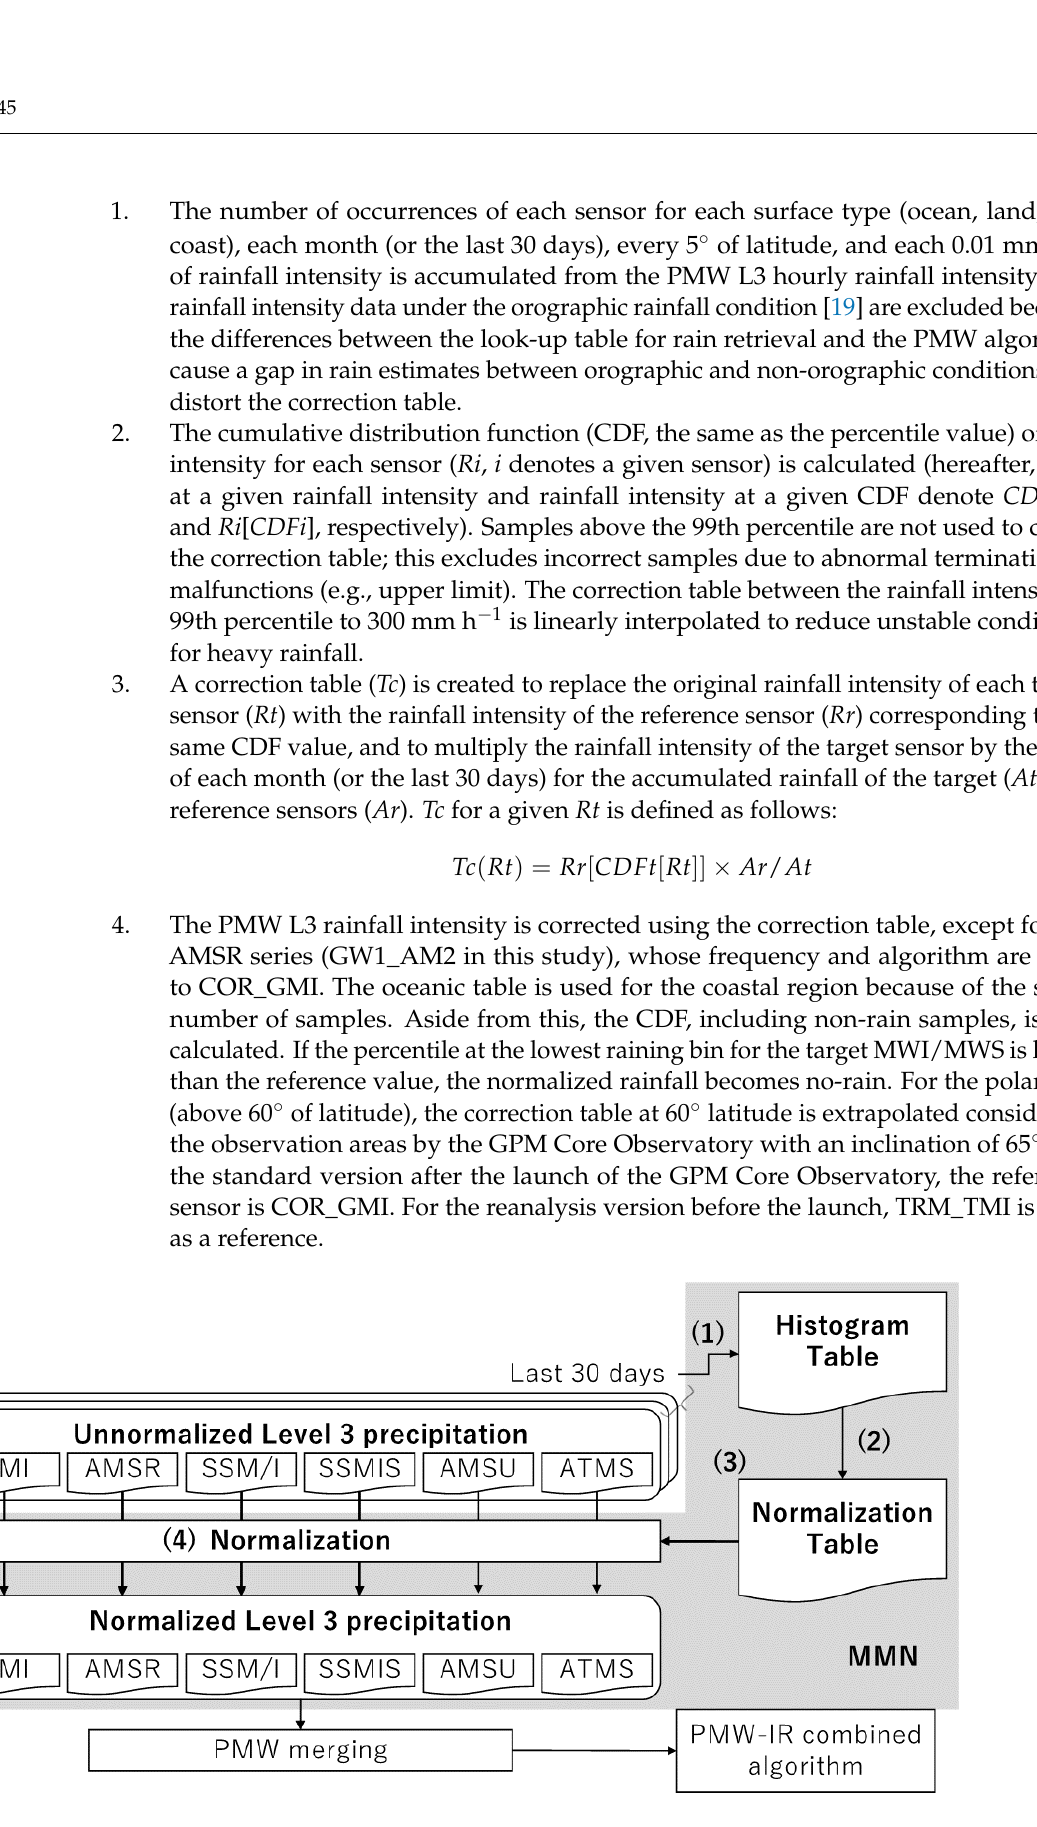
Figure 1. Process flowchart of the MMN module. Numbered list corresponds to the steps in Section